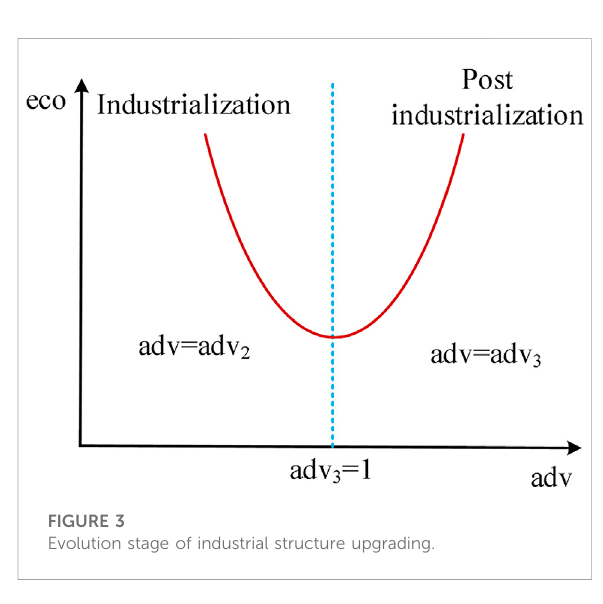
FIGURE 3 Evolution stage of industrial structure